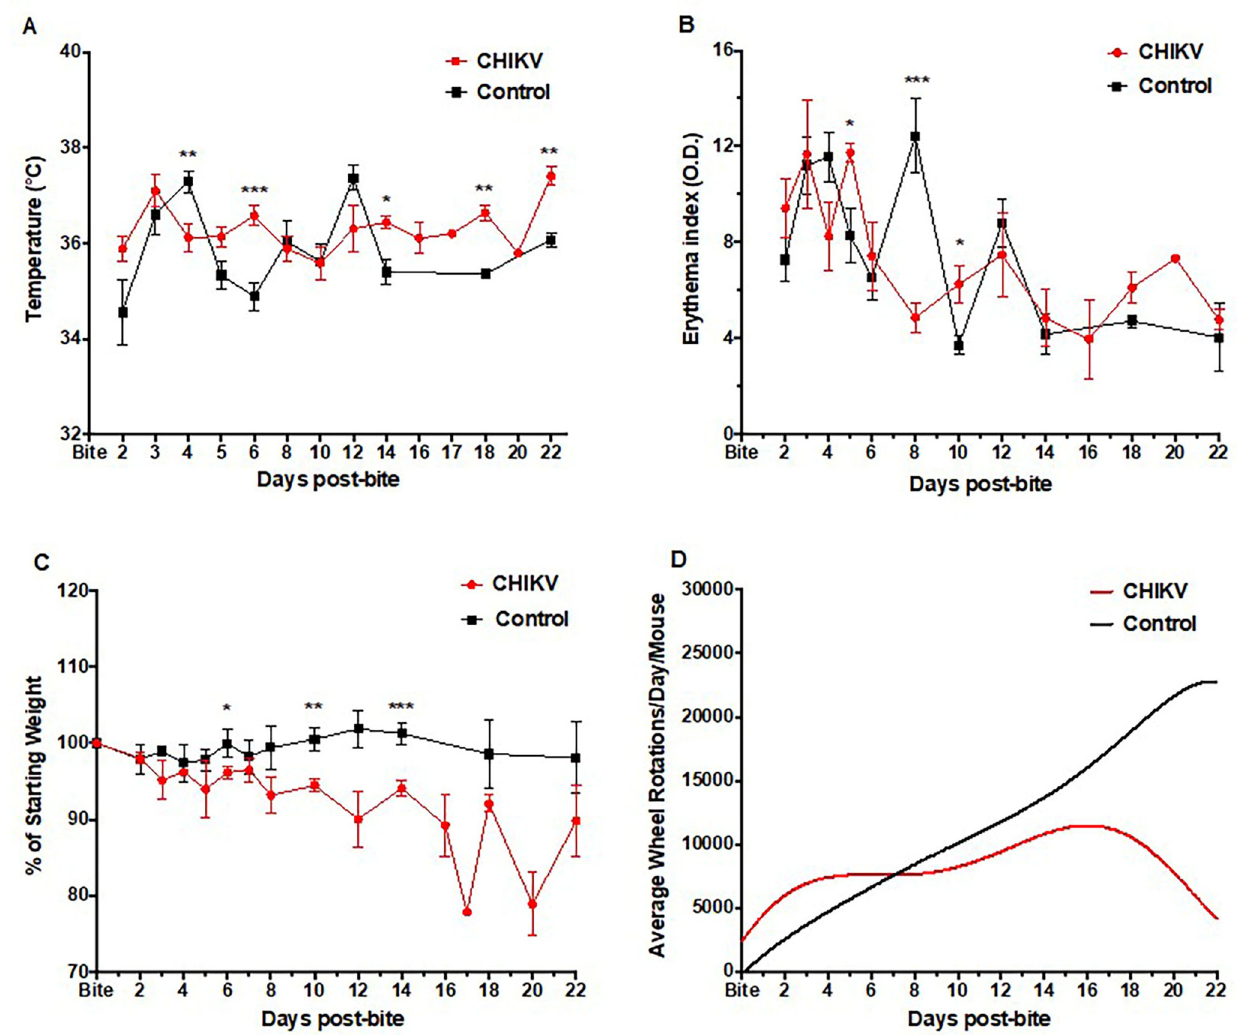
Fig 2. Clinical signs of CHIKV infection in Hu-NSG mice after natural transmission via mosquito bite. ( A ) Temperature, ( B ) erythema index, ( C ) weight change, and ( D ) activity levels (wheel rotations) of mosquito-bitten CHIKV-infected mice as compared to uninfected control mice bitten with non- infected mosquitoes were assessed as a measure of disease up to 22 days post-infection. CHIKV-infected mouse data are shown in red, while uninfected control mice data are indicated in black. Unpaired t-tests were used to determine statistical significance between CHIKV-infected and uninfected mice at each time point. Asterisks indicate significance differences ( � p < 0.05; �� p < 0.01; ��� p < 0.005). Error bars indicate SEM. Wheel rotation curves were generated by a sixth order polynomial. Mice per group: n �